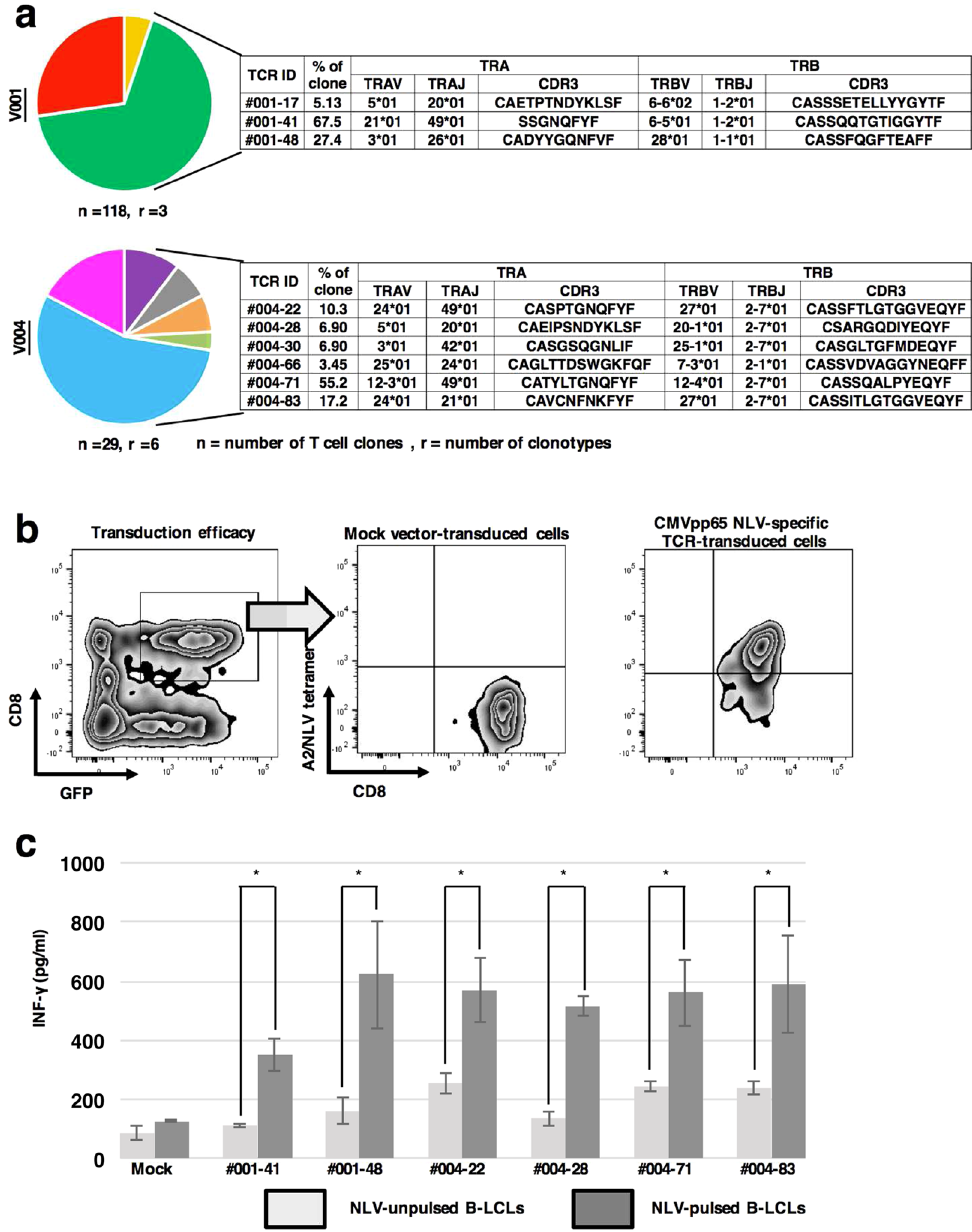
Figure 2. Characterization of CMV NLV-specific TCR α and TCR β repertoires of single cells. ( a ) CMV NLV- specific TCR α and TCR β repertoires identified using single-cell multiplex clonotypic analysis of two HLA- A2-positive and CMV-seropositive healthy donors (V001 and V004). Single CMV NLV-specific T cells were sorted into 96-well PCR plates and then cDNAs were amplified using multiplex RT-PCR. The PCR products were sequenced and conceptually translated to identify CDR3 α and CDR3 β . We analysed 118 and 29T cells from V001 and V004, respectively, and identified 3 (TCR ID; 001-17, 48 and 41) and 6 (TCR ID; 004-66, 22, 63, 30, 28 and 71) CDR3 α and CDR3 β pairs from each respective donor. ( b ) Transduction of sequences encoding CMV NLV-specific TCRs. TCR α and TCR β pairs were cloned into expression vectors encoding GFP that were used to transfect PHA blasts derived from a CMV-seronegative healthy donor. Representative flow cytometric profiles illustrate transduction efficiencies. Cells with double-positive staining for the NLV tetramer and GFP were considered successful transductants. ( c ) IFN- γ production by TCR-transduced cells. TCR-transduced cells were co-cultured for 16 h with NLV-pulsed and NLV-unpulsed B-LCLs derived from the cognate donors. The IFN- γ concentrations in culture supernatants were measured using an IFN- γ ELISA. The results represent the mean ± standard deviation (S.D.) of triplicate experiments. The error bars represent standard deviation. The asterisks indicate significant difference (p < 0.05) in the IFN- γ concentrations between samples co-cultured with NLV-pulsed and NLV-unpulsed B-LCLs (paired t-test). Although mock-transduced PHA blasts did not recognize NLV peptide-pulsed or control B-LCLs, all TCR-transduced PHA blasts recognized only NLV peptide-pulsed B-LCLs, verifying the antigenic specificity of the TCR-transduced PHA